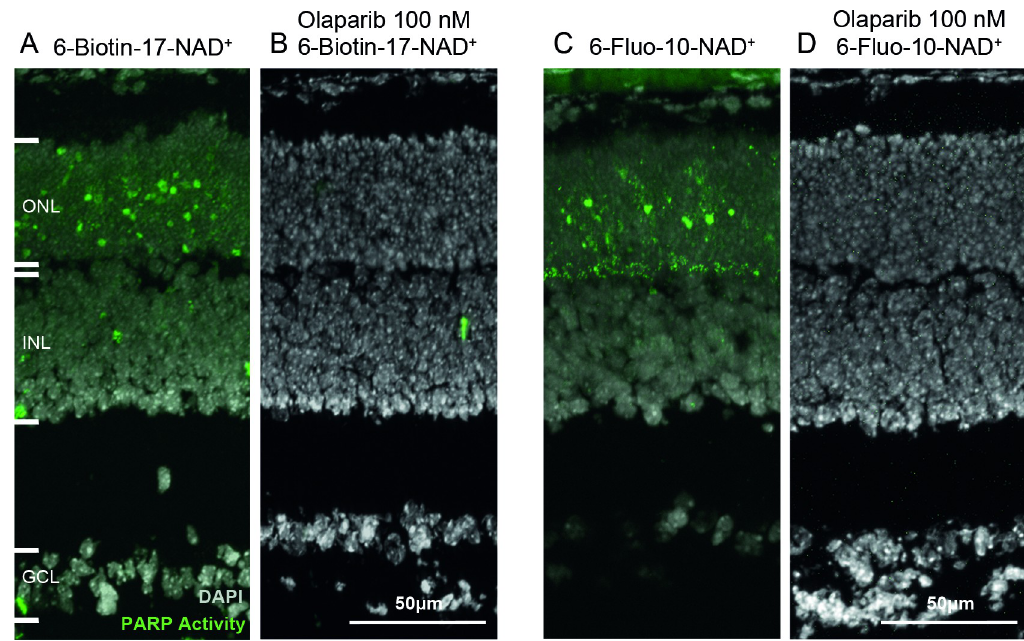
Fig 4. The PARP inhibitor olaparib abolishes PARP activity signals. Retinal sections derived from post-natal (P) day 11 rd1 animals were incubated with NAD + analogues, together with the selective PARP inhibitor olaparib. In both the two-step assay with 6-Biotin-17-NAD + ( A , B ) and the single-step assay using 6-Fluo-10-NAD + ( C , D ), olaparib, at 100 nM, completely abolished positive PARP activity detection. DAPI was used as nuclear counterstaining. ONL = outer nuclear layer, INL = inner nuclear layer, GCL = ganglion cell layer. Images representative for assays performed on tissue sections derived for at least three different rd1 animals per assay condition. https://doi.org/10.1371/journal.pone.0245369.g004 specific disease pathomechanisms, for instance. Another way to assess PARP activity in whole tissue lysates is to perform an activity blot. Using whole tissue samples, the technique combines western blotting followed by a protein renaturation and activity assay. A labelling will be seen in protein bands with molecular weights corresponding to PARP enzymes [25]. While this technique may allow attributing activity to specific protein bands or isoforms, again, the